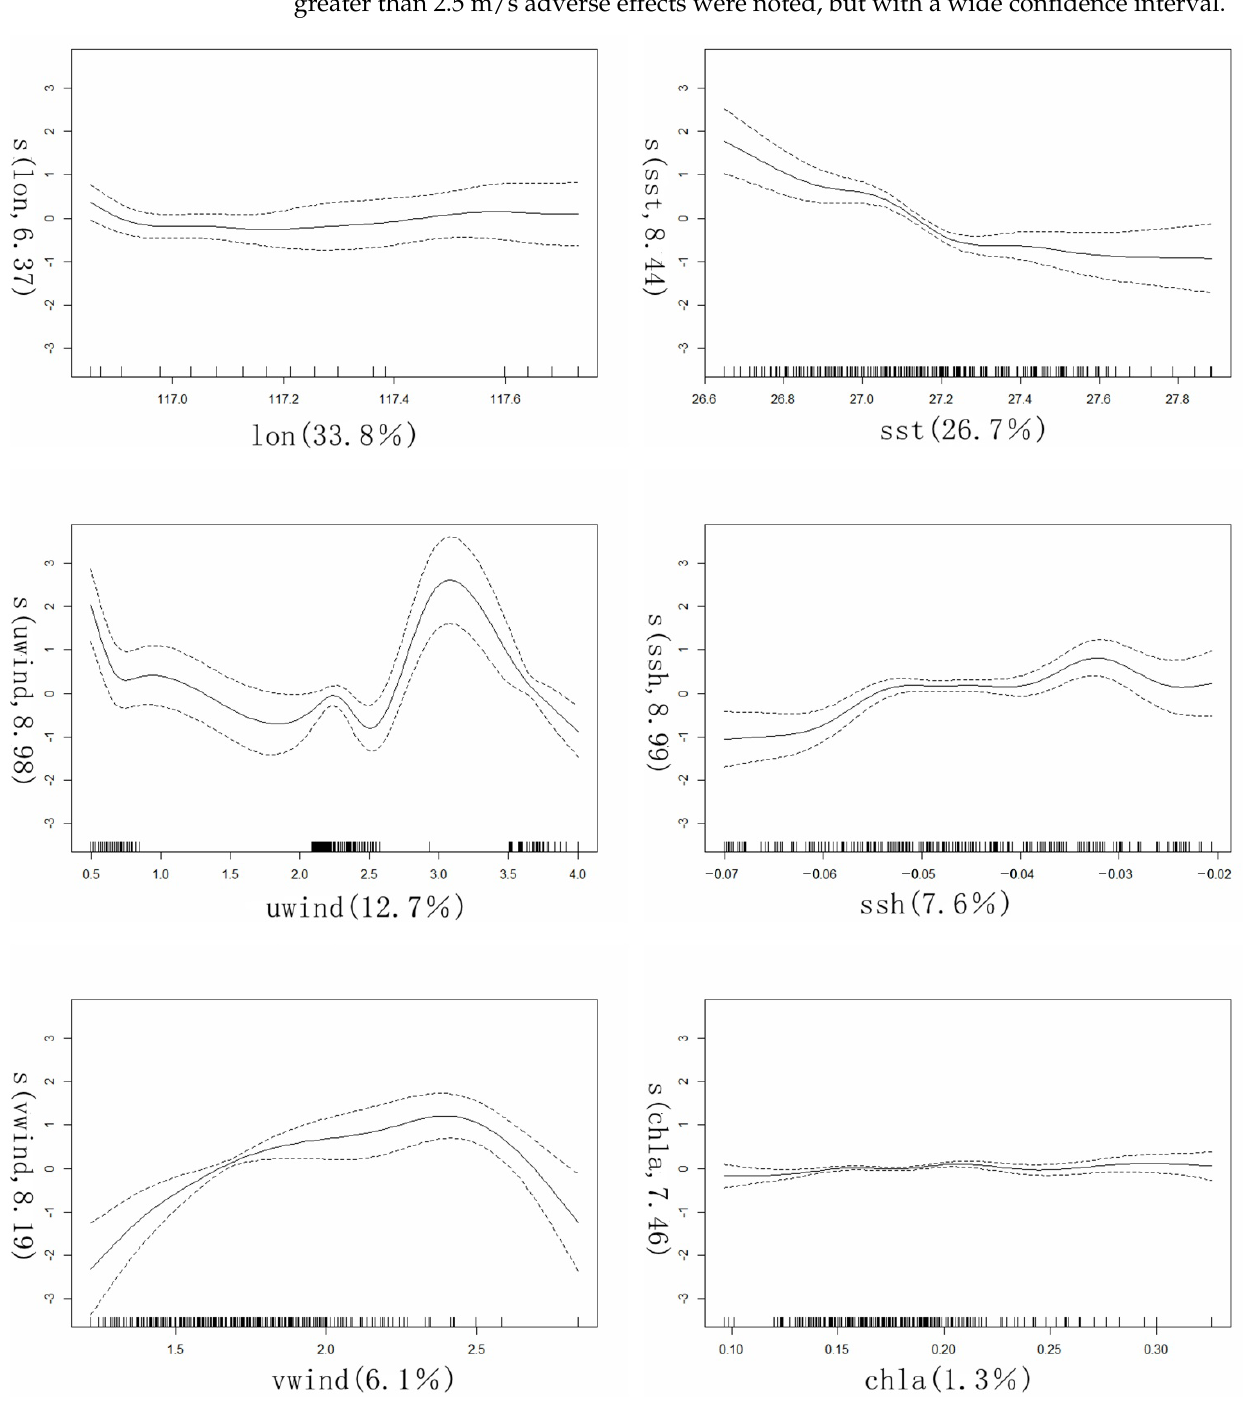
Figure 7. Partial effect plots of the variables retained in the final model. The vertical coordinate represents the spline function s(x). The numbers in parentheses are the estimated degree of freedom. Dashed line indicates 95% confidence band and ticks on the horizontal coordinate denote the data points. lon is longitude, sst is sea surface temperature, uwind is zonal sea surface wind, ssh is sea surface high, vwind is meridional sea surface wind, chla is Chlorophyll-a